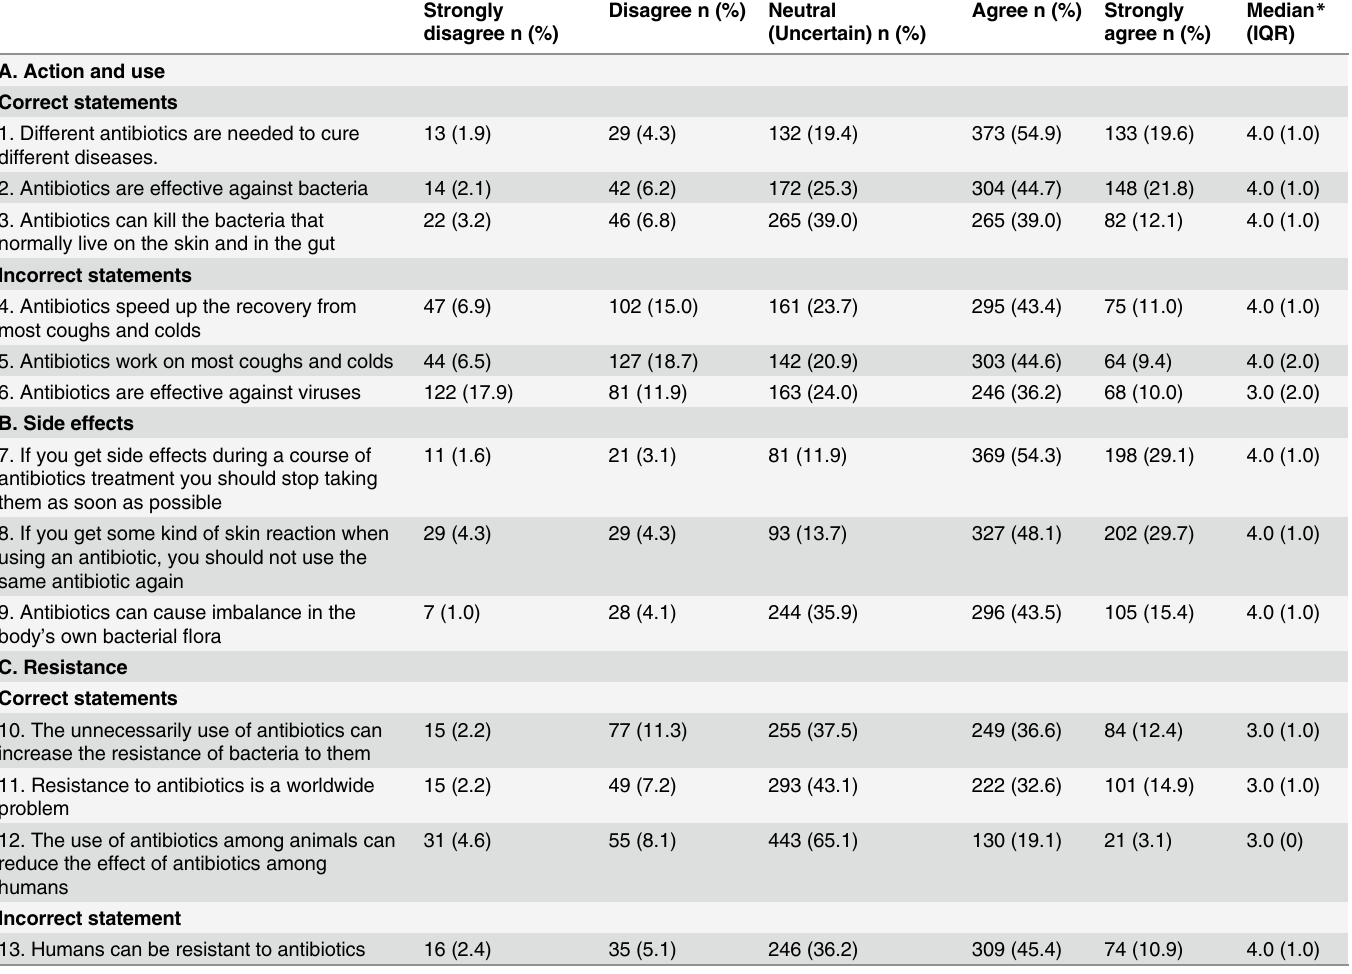
Table 2. Respondents ’ Knowledge regarding Antibiotics (n =